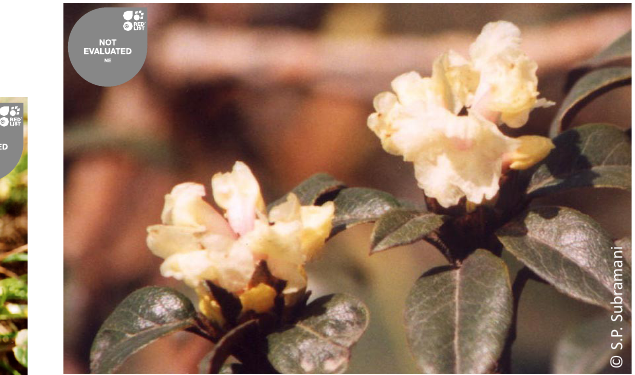
Image 12. Rhododendron anthopogon